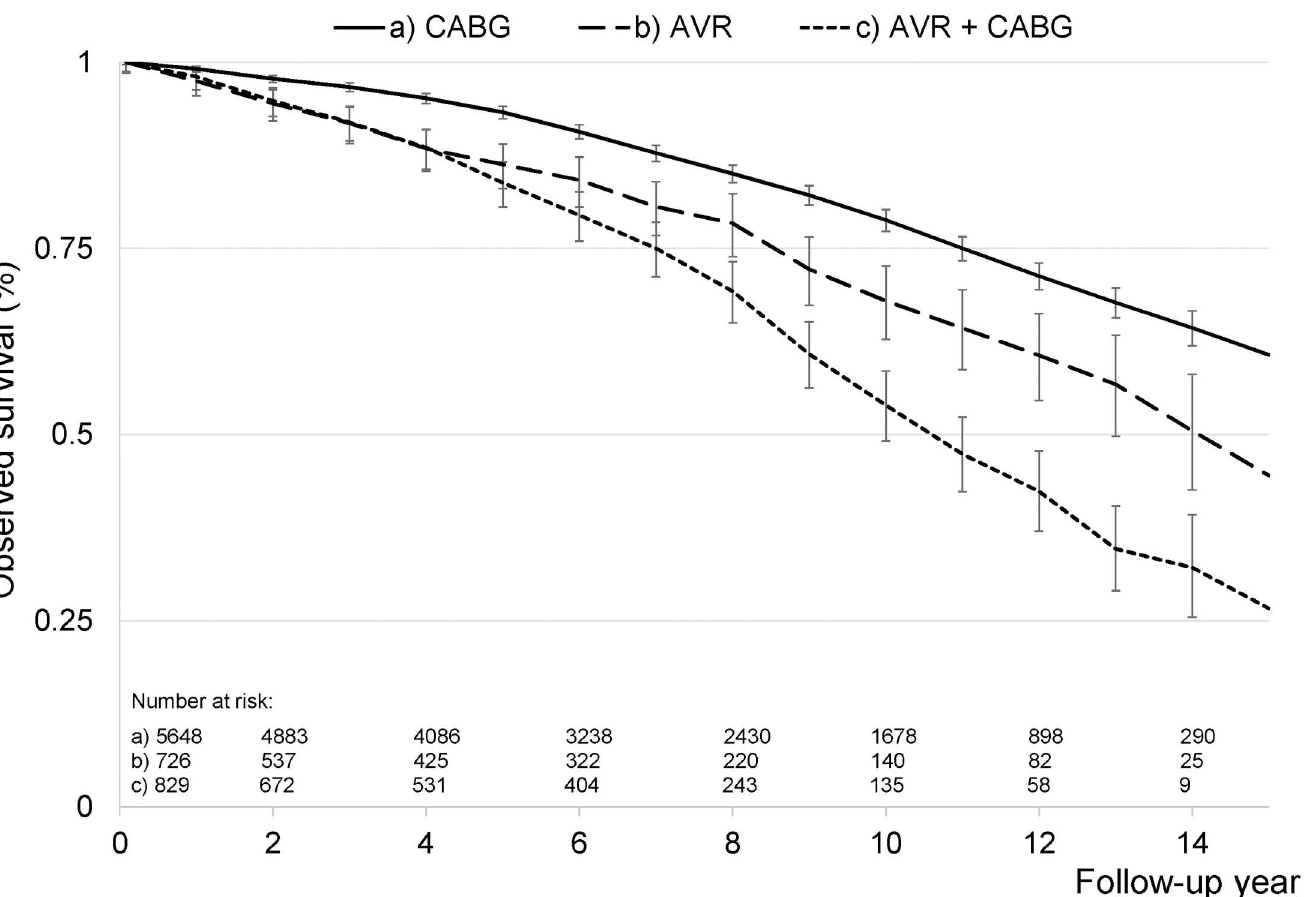
Fig 2. Long-term observed survival. UnadjustedKaplan-Meier survival curves for patients undergoing coronary artery bypass grafting (CABG) and/or aortic valve replacement (AVR). The number at risk (n) at the start of even follow-upyears are provided.